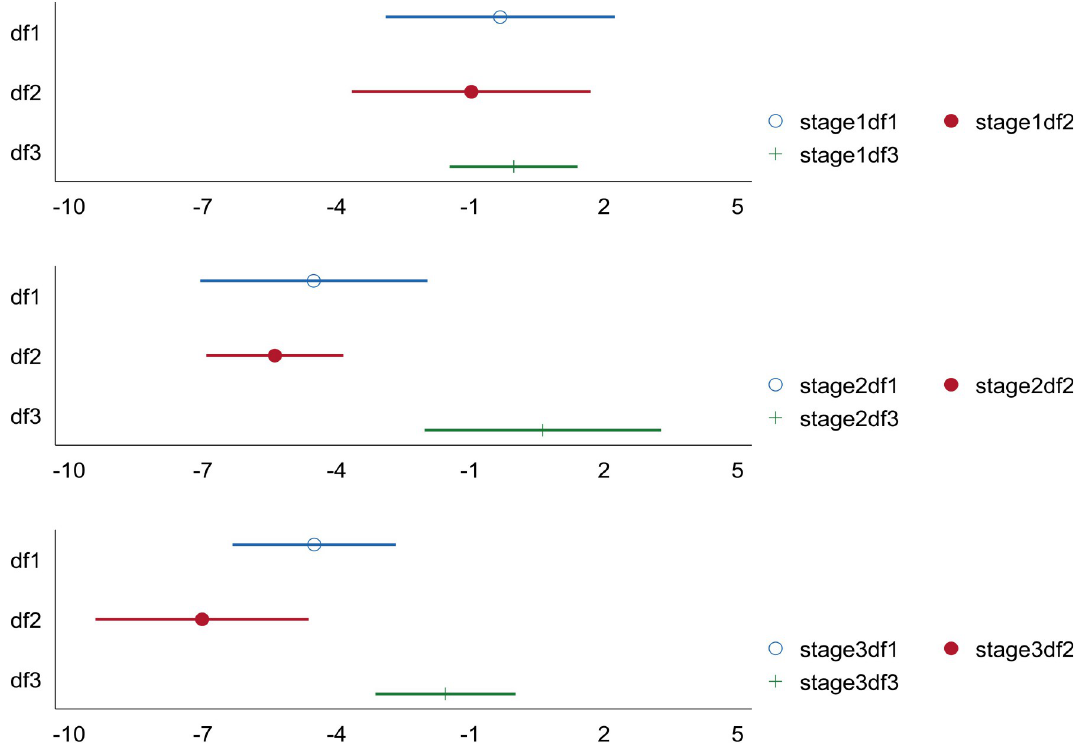
Fig 3. Marginal effects of three stages df1, df2 and df3 on pol in three